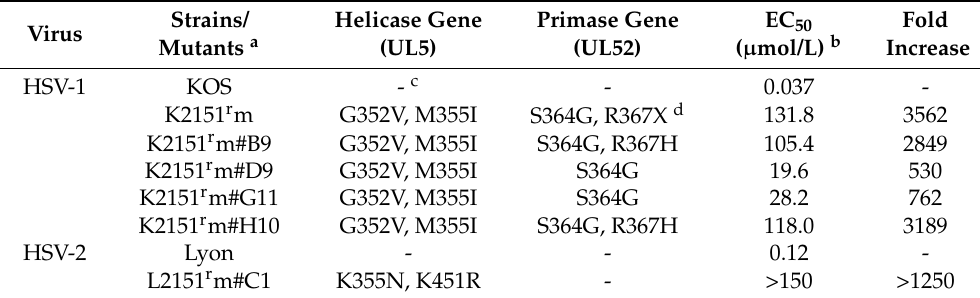
Table 1. Amino acid substitutions in the helicase and primase of ASP2151-resistant HSV-1 and HSV-2 mutants, and susceptibility to ASP2151 [14].